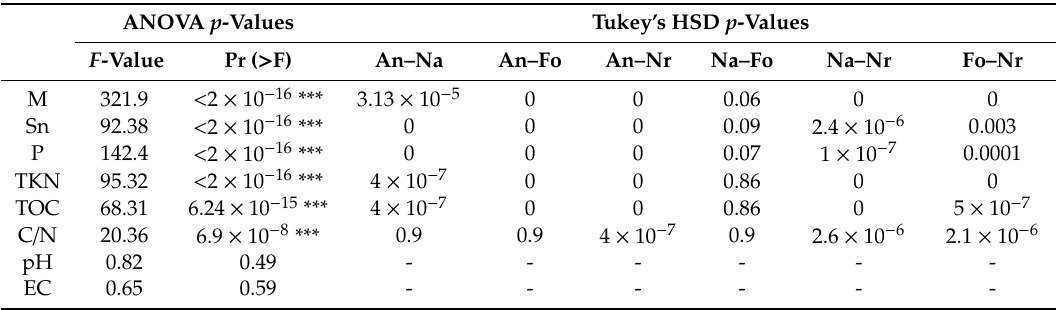
Table 1. Analysis of variance and Tukey’s honest significant di ff erence (HSD) p -values of the studied variables and soil types.